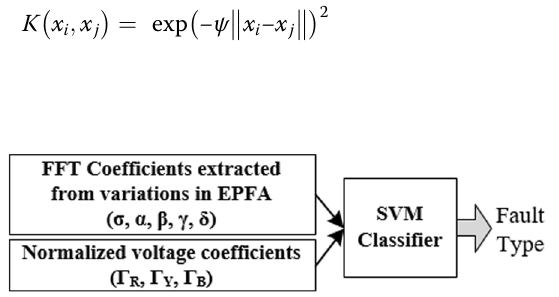
Fig. 10 Functional block diagram of SVM classifier for fault classification Fig. 11 Single line diagram of IEEE-39 bus